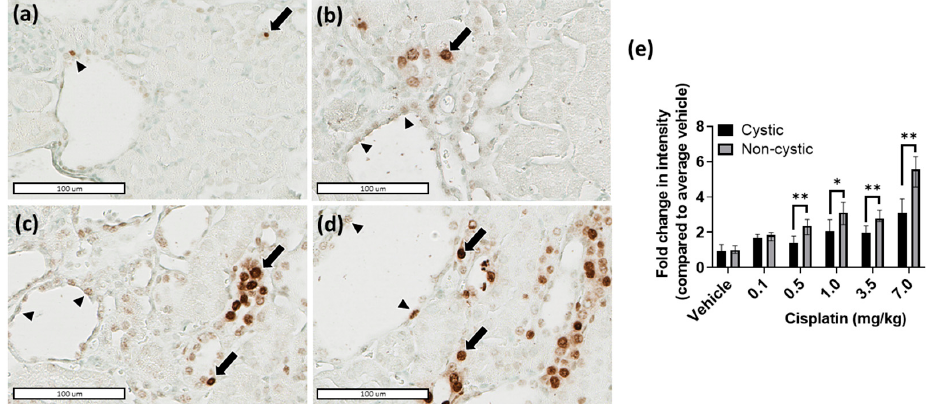
Figure 1. Cyst lining epithelia are resistant to cisplatin-induced DNA damage. Immunohistochemical staining for γ H2AX in kidney cortical sections of Pkd1 RC/RC /Atm +/ − mice treated with ( a ) vehicle, ( b ) 1.0 mg/kg cisplatin, ( c ) 3.5 mg/kg cisplatin and ( d ) 7.0 mg/kg cisplatin, demonstrating increased staining intensity of non-cystic tubules (arrows) compared to cyst lining epithelia (arrowheads); ( e ) Histogram showing fold change of γ H2AX intensity from baseline (vehicle) in cyst lining epithelia and non-cystic tubules of Pkd1 RC/RC /Atm +/ − kidneys. Graphs showing median values with error bars representing upper and lower quartiles. Scale bar = 100 µm. * p < 0.01; ** p < 0.001.